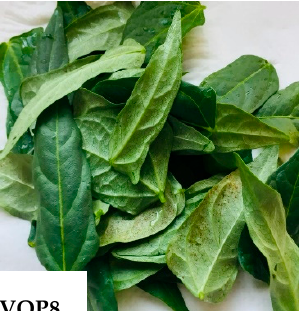
Figure 1. Di ff erent cowpea cultivars used in this Figure 1. Different cowpea cultivars used in this study.